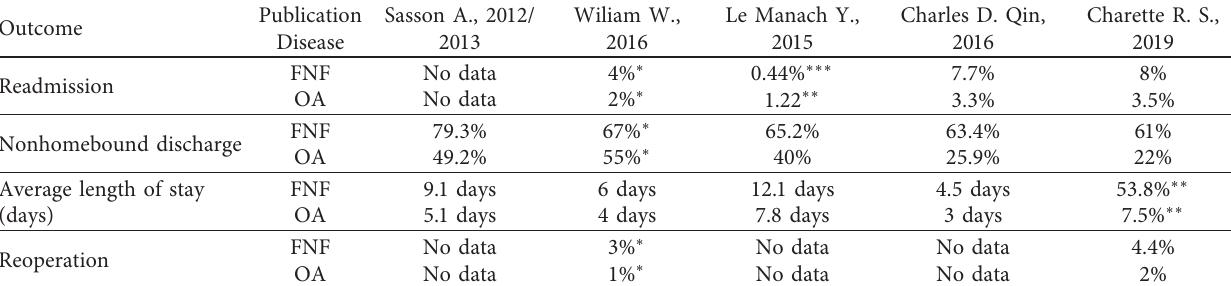
Table 5: Outcome